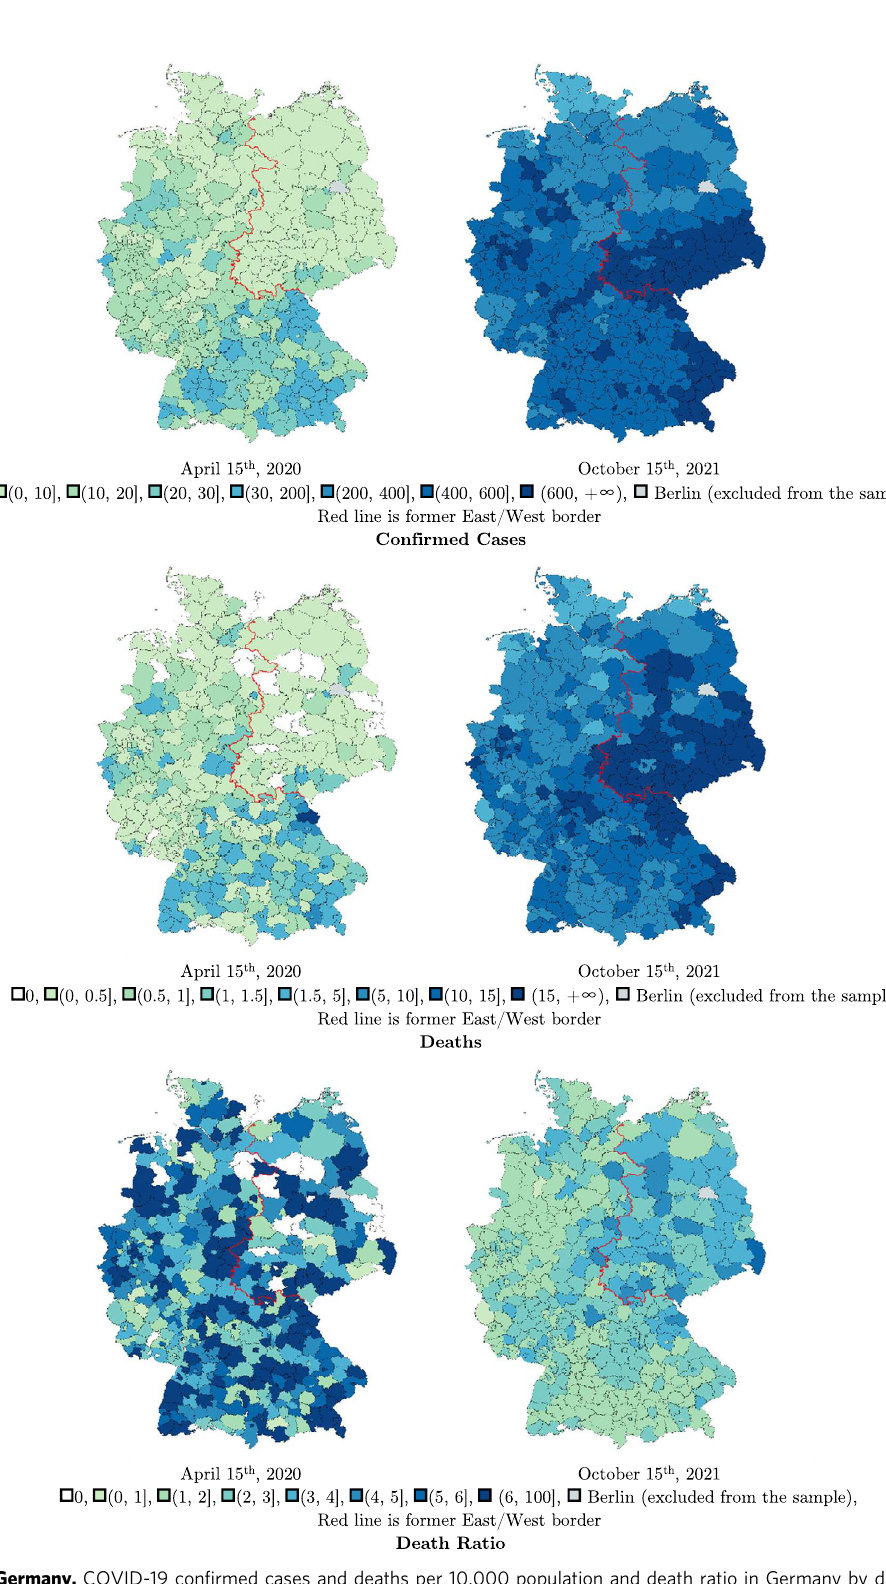
Fig. 4 COVID-19 in Germany. COVID-19 con fi rmed cases and deaths per 10,000 population and death ratio in Germany by